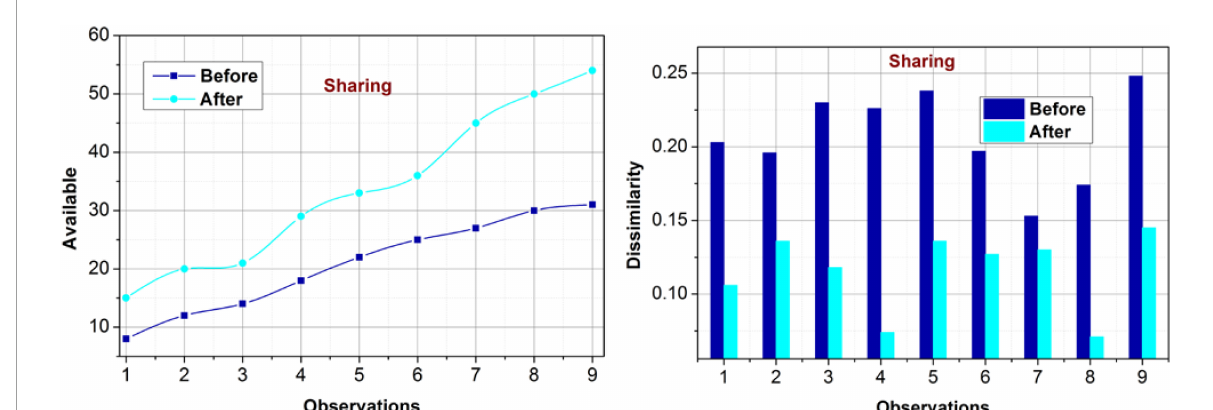
FIGURE8 Availability and dissimilarity (sharing).